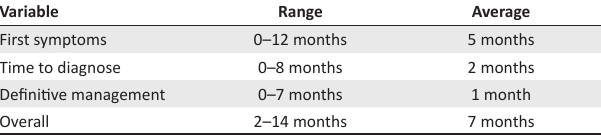
TABLE 1: Timeline of delay (derived from chart